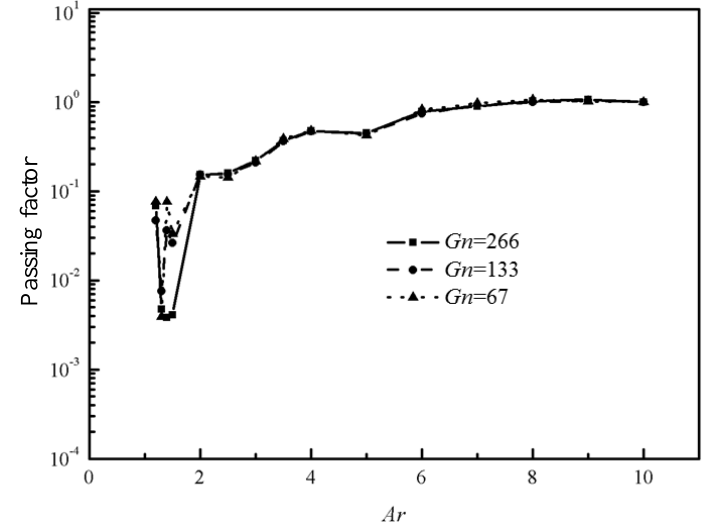
Figure 10. The passing factor PF with different Gn ( ϕ s = 0.46).